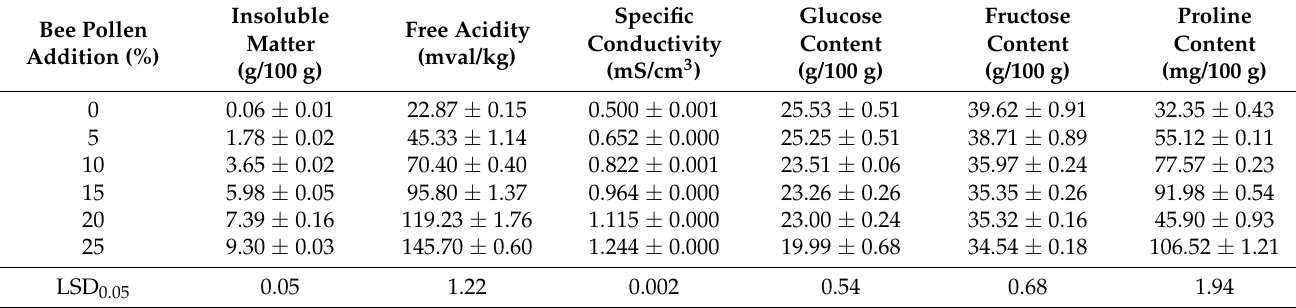
Table 4. The qualitative parameters of multiflower honey and honey samples enriched with bee pollen. Bee